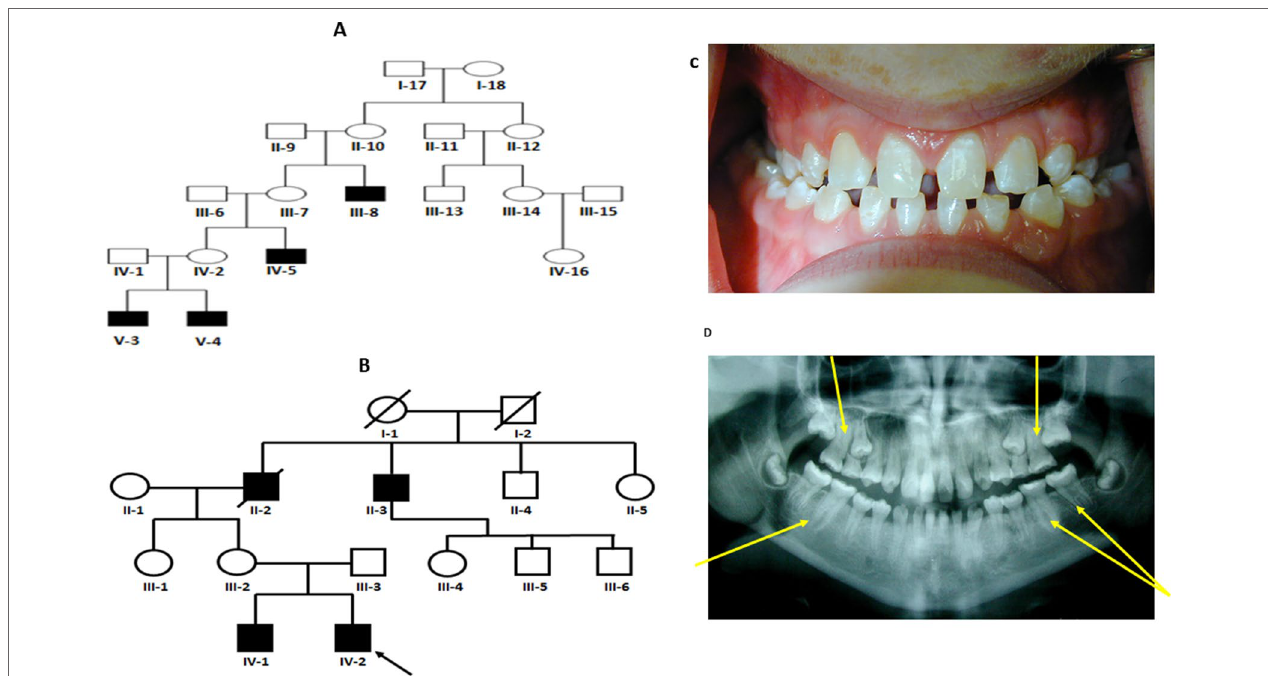
FIGURE 1 | (A and B) Pedigree for family 1 and 2 showing affected males shaded in black. Individuals included in segregation analyses in the family are shown with black Panel (C) Frontal view from one twin 1 from family 1 showing generalized microdontia and spacing. Panel (D) is a panoramic radiograph from the same twin as above. He is in the late mixed dentition, as his maxillary second premolars have not yet erupted. Taurodontism in the molars is evident (arrows).